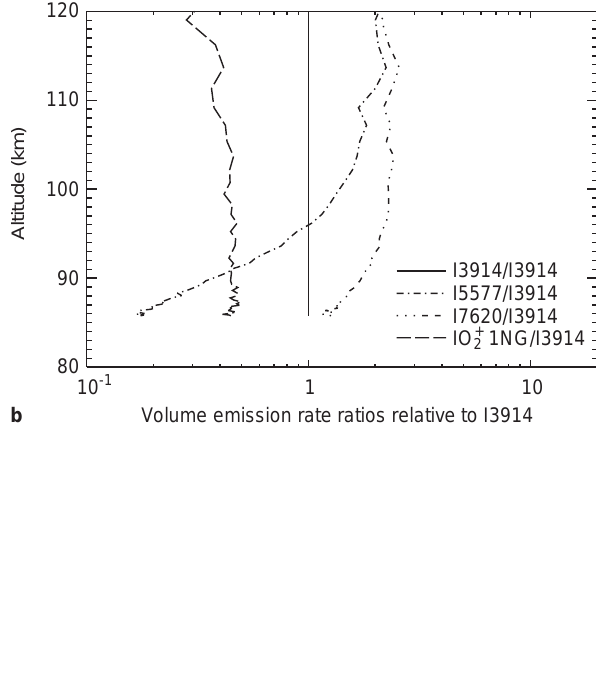
Fig. 4. a Optical emission rates relative to I(3914 A˚ ) for normal [NO] and a 50 keV monoenergetic electron spectrum. b Same